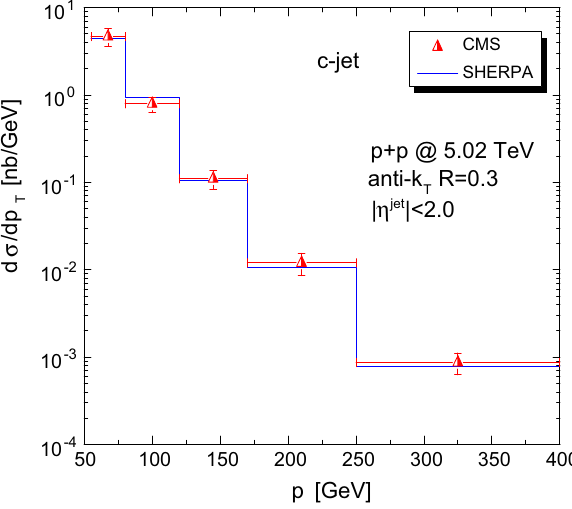
Fig. 2 The c-jet cross section versus c-jet transverse momentum in p + p collisions at 5 . 02 TeV with R = 0 . 3 and | η jet | < 2 . 0 and compared with CMS data